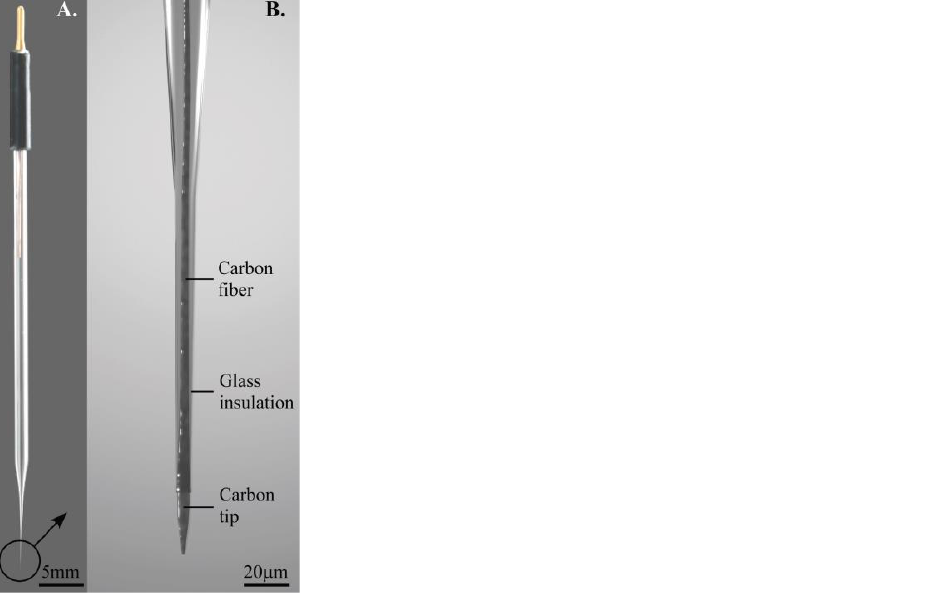
Figure 7. ( A ) View of a carbon fiber microelectrode, and ( B ) microstructure of the tip (reprinted with permission from Ref.